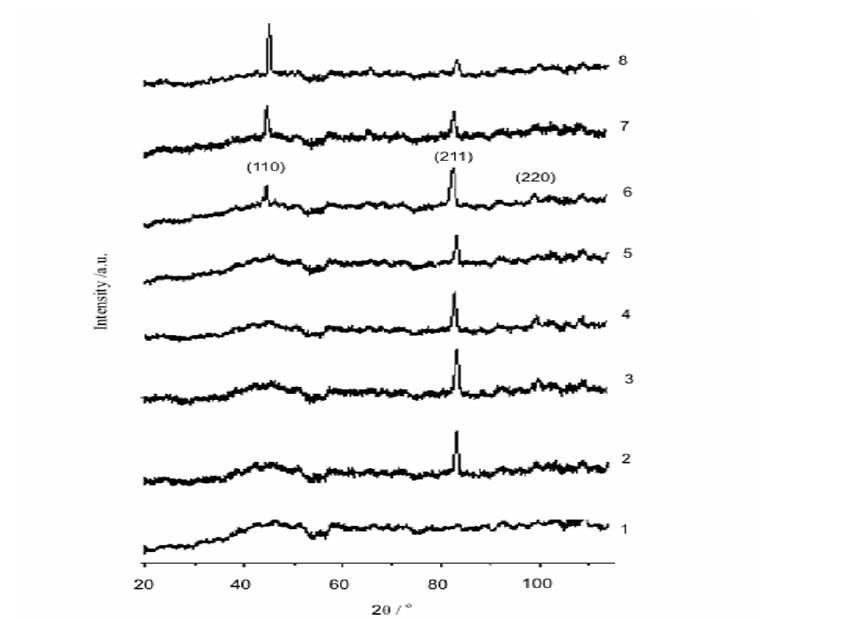
Figure 1 – XRD patterns of the amorphous Fe 81 B 13 Si 4 C 2 alloy in different states, annealed